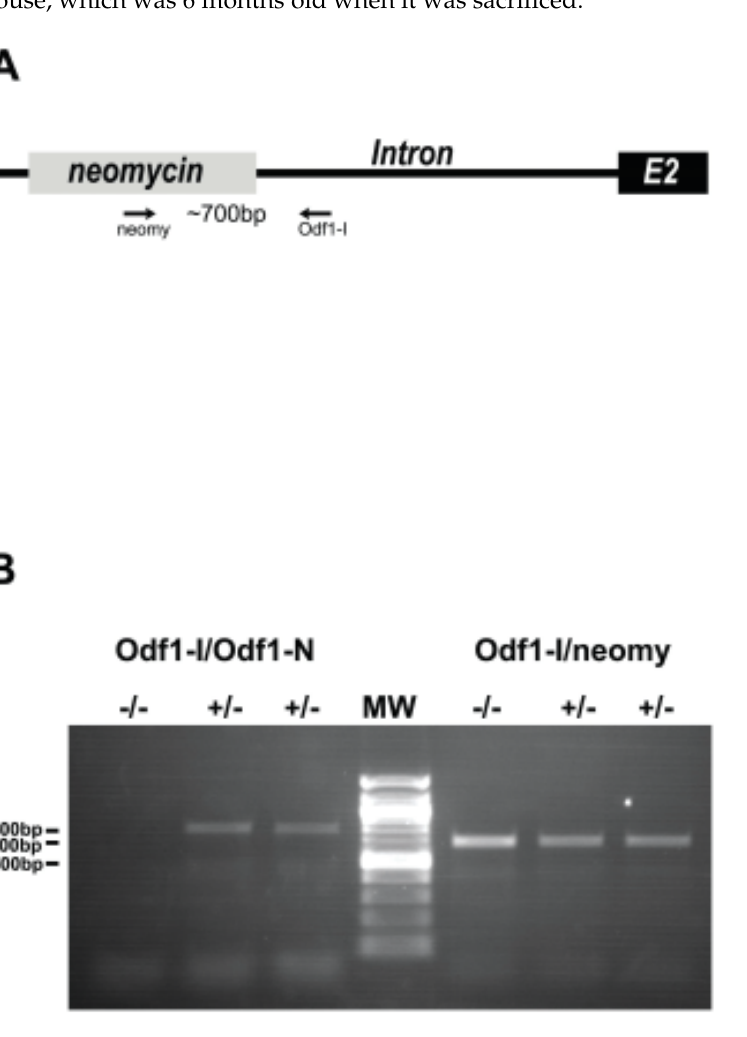
Figure 1. Genotyping of Odf1 -deficient mice. ( A ) Replacement of exon 1 by neomycin. The positions of the primer pair for amplification of the insertion are indicated. A product of ~700 bp is expected. E2 = exon 2. ( B ) Genotyping of homozygous ( − / − ) and heterozygous (+/ − ) Odf1 -deficient mice. Amplification of exon 1 of Odf1 with the primer pair Odf1-I/Odf1-N and of the neomycin insertion with primer pair Odf1-I/neomy. The neomycin insertion was amplified in homozygous Odf1 -deficient mice ( − / − ) but not exon 1 of Odf1 . MW = 100 bp ladder.